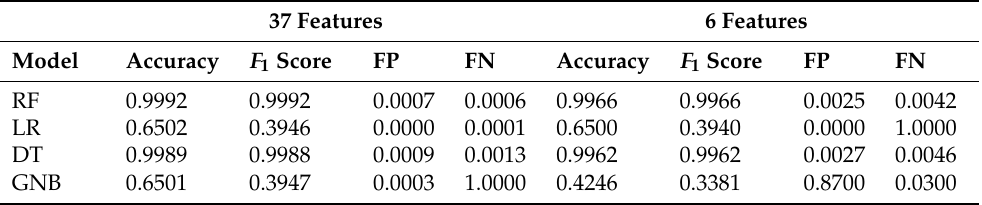
Figure 2. F 1 Score change with change in number of features. Table 2. Classifiers’ Performance Before and After Feature